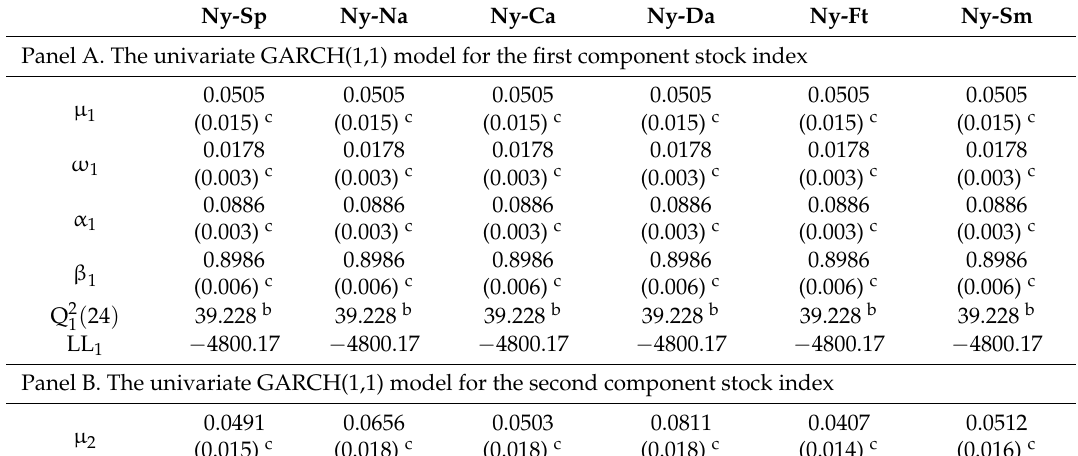
Table 2. The empirical results of NS-ADCC model. Ny-Sp Ny-Na Ny-Ca Ny-Da Ny-Ft Ny-Sm